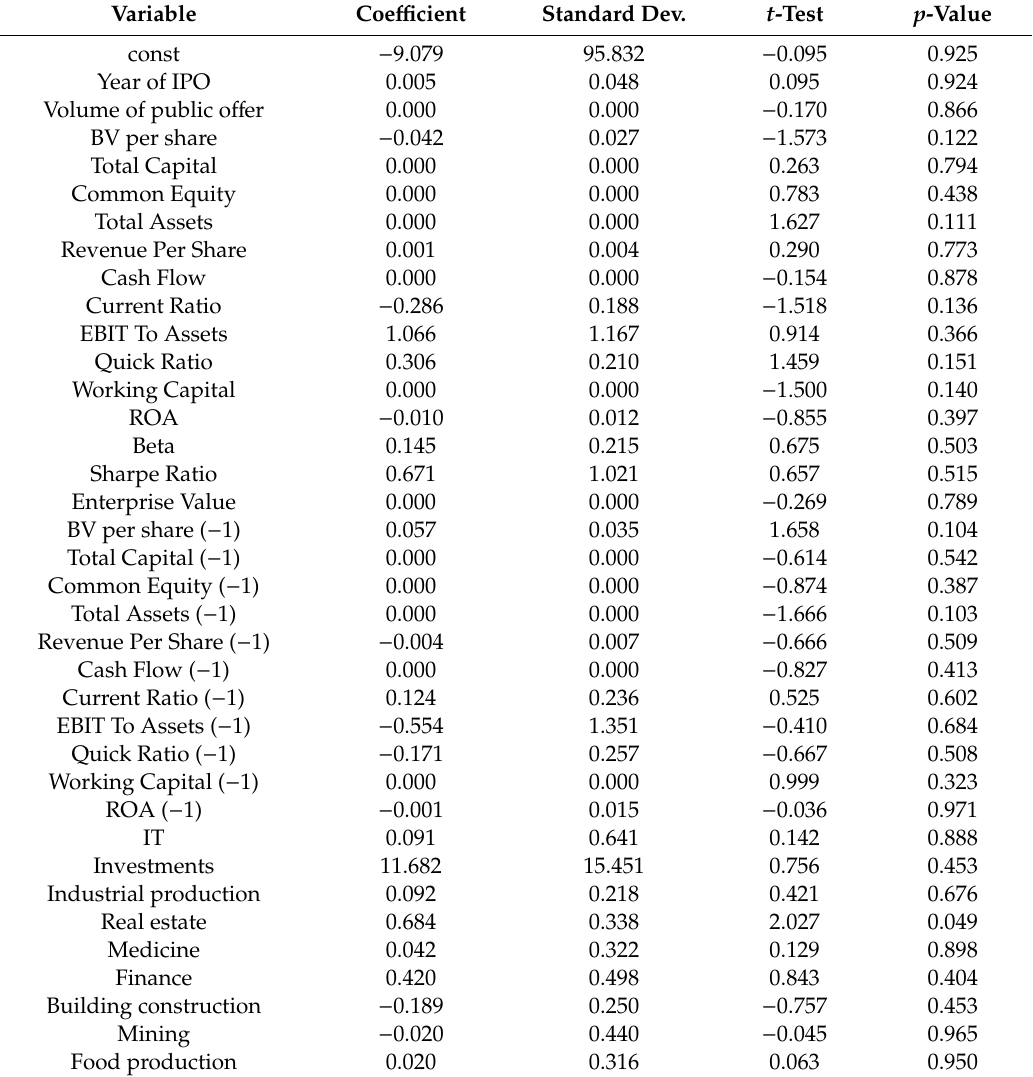
Table A1. Initial model of the marketability